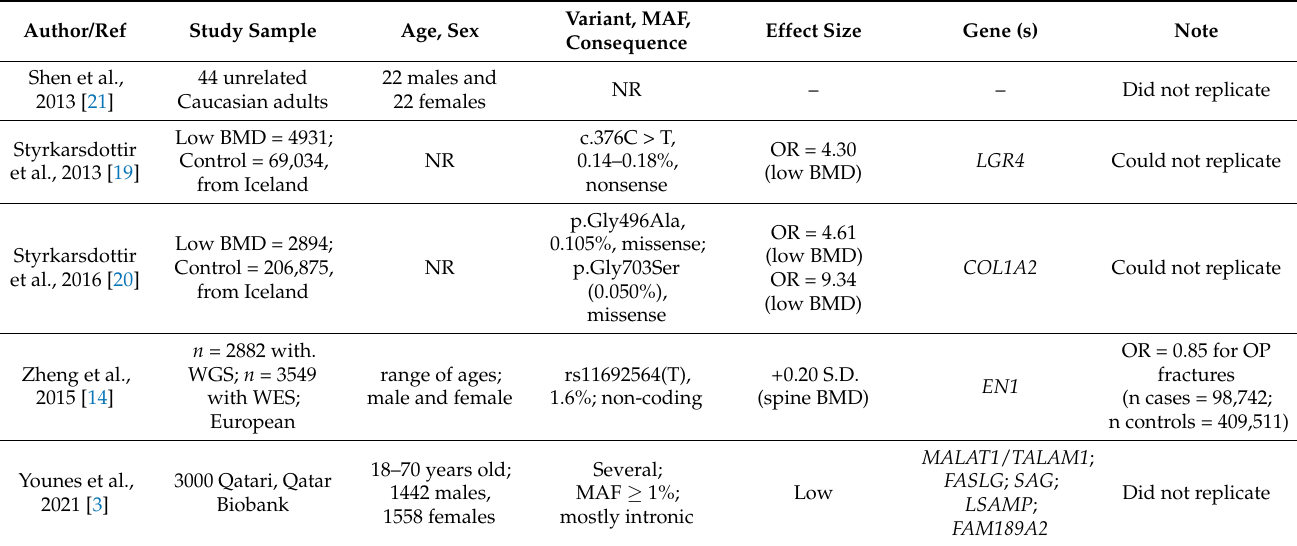
Table 1. WGS studies in bone